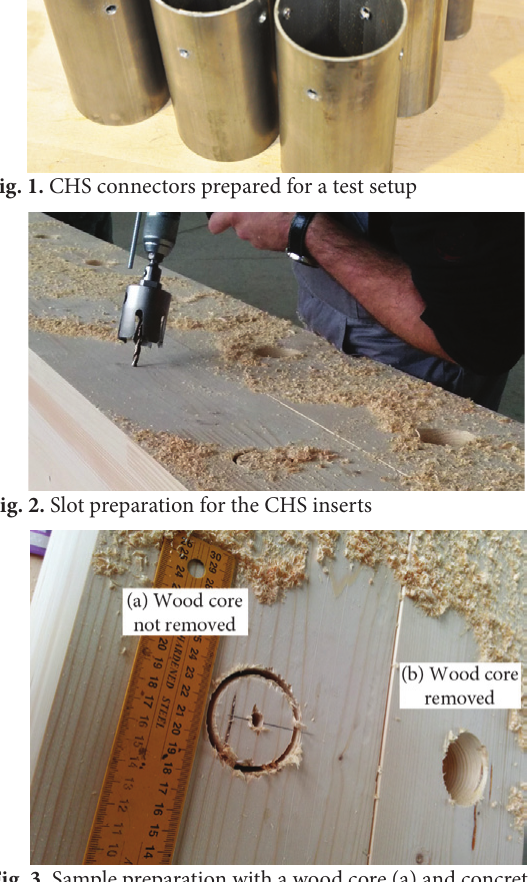
Fig. 3. Sample preparation with a wood core (a) and concrete in-fill core